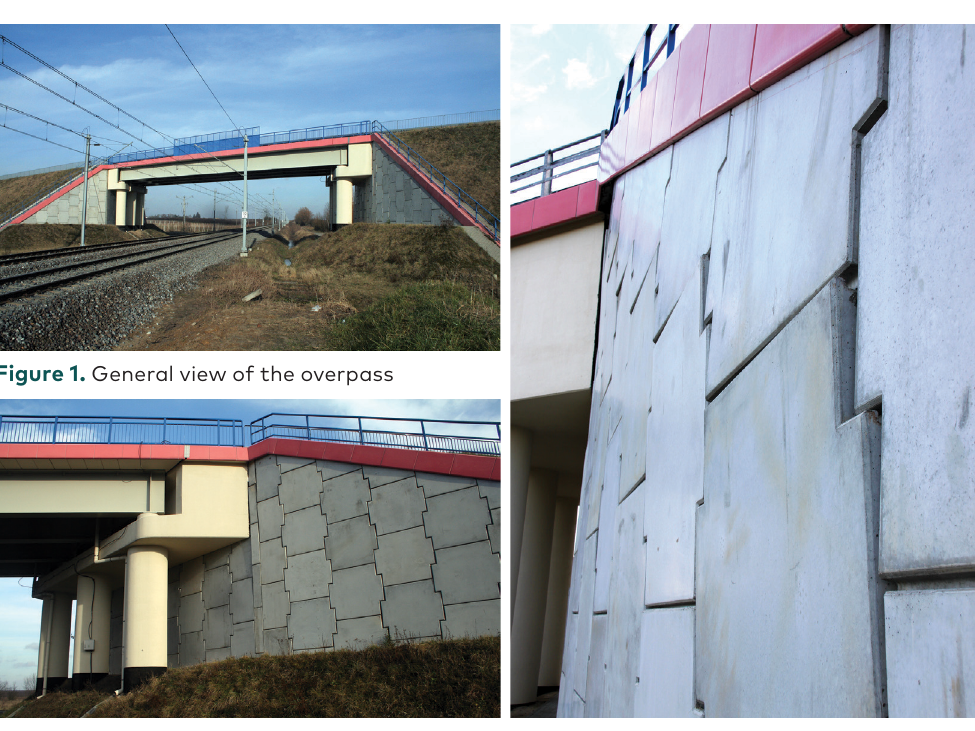
Figure 2. View of the facade elements of the abutment retaining structure